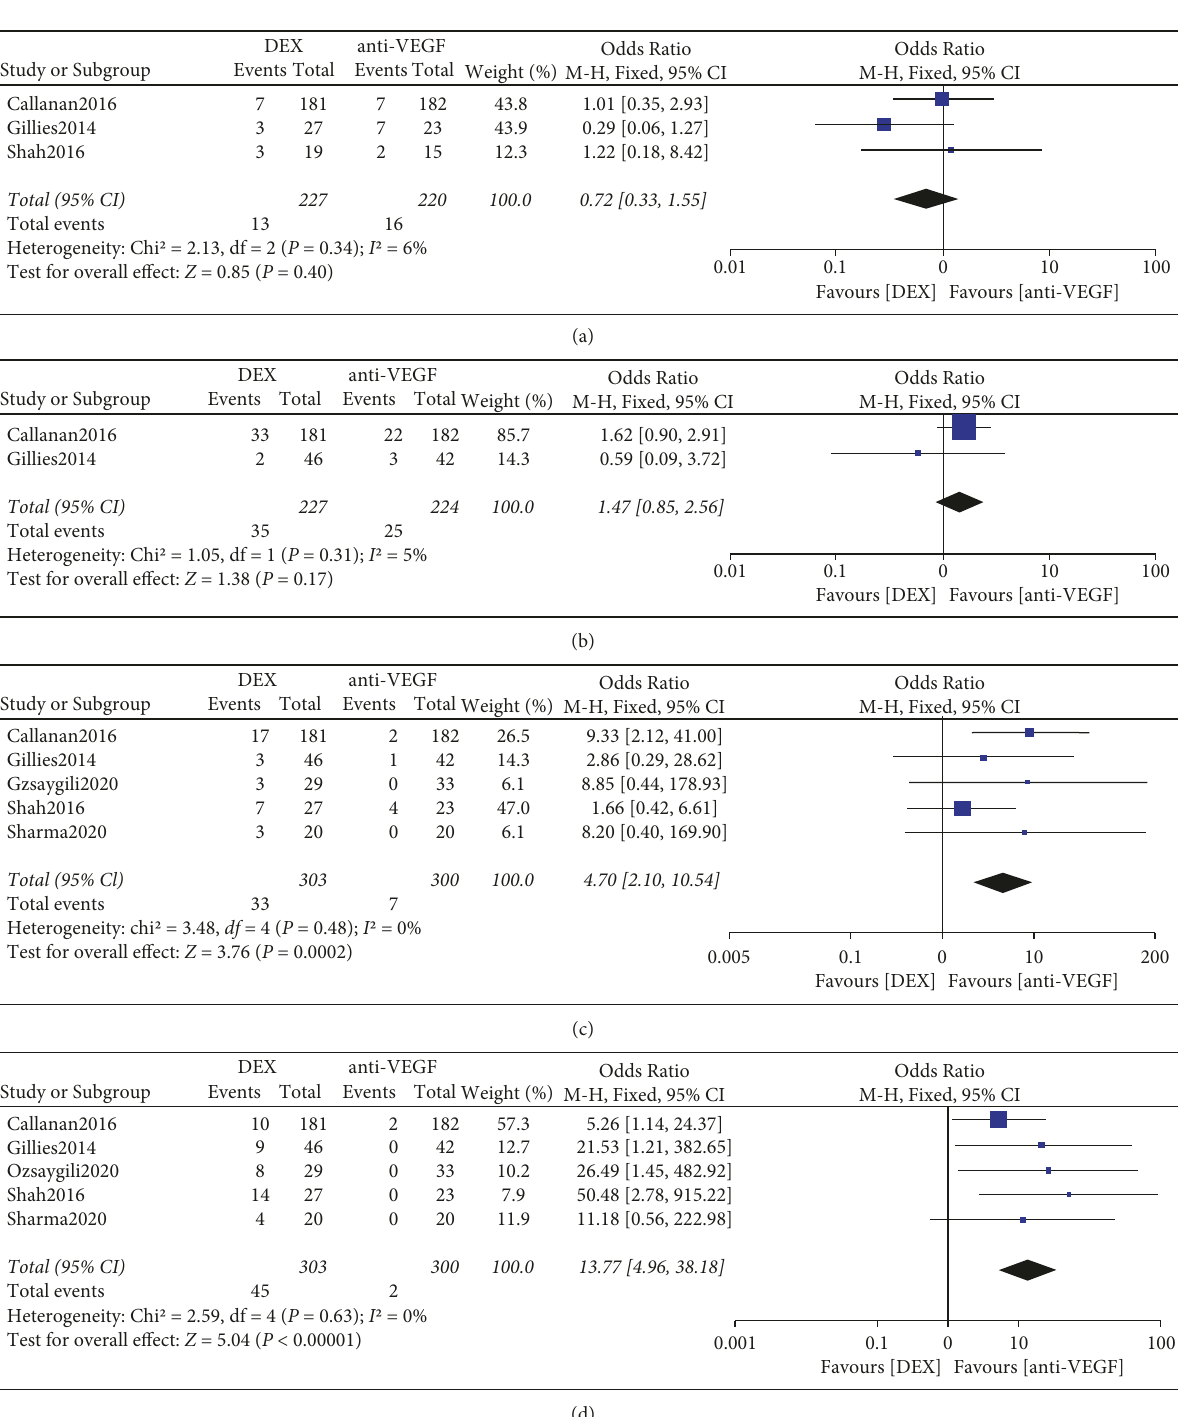
Figure 5: (a) Forest plot of SAEs, (b) conjunctival hemorrhage, (c) cataract or cataract exacerbation, and (d) high IOP for